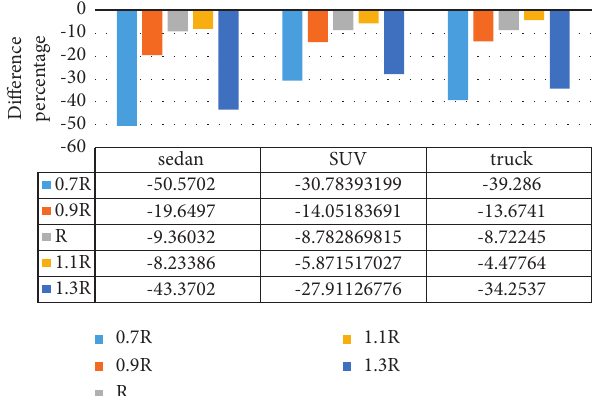
Figure 13: Difference percentage between the roll rates of simple and spiral horizontal curves with respect to that of the simple horizontal curve for the speed of 100km/h and various radius percentages.